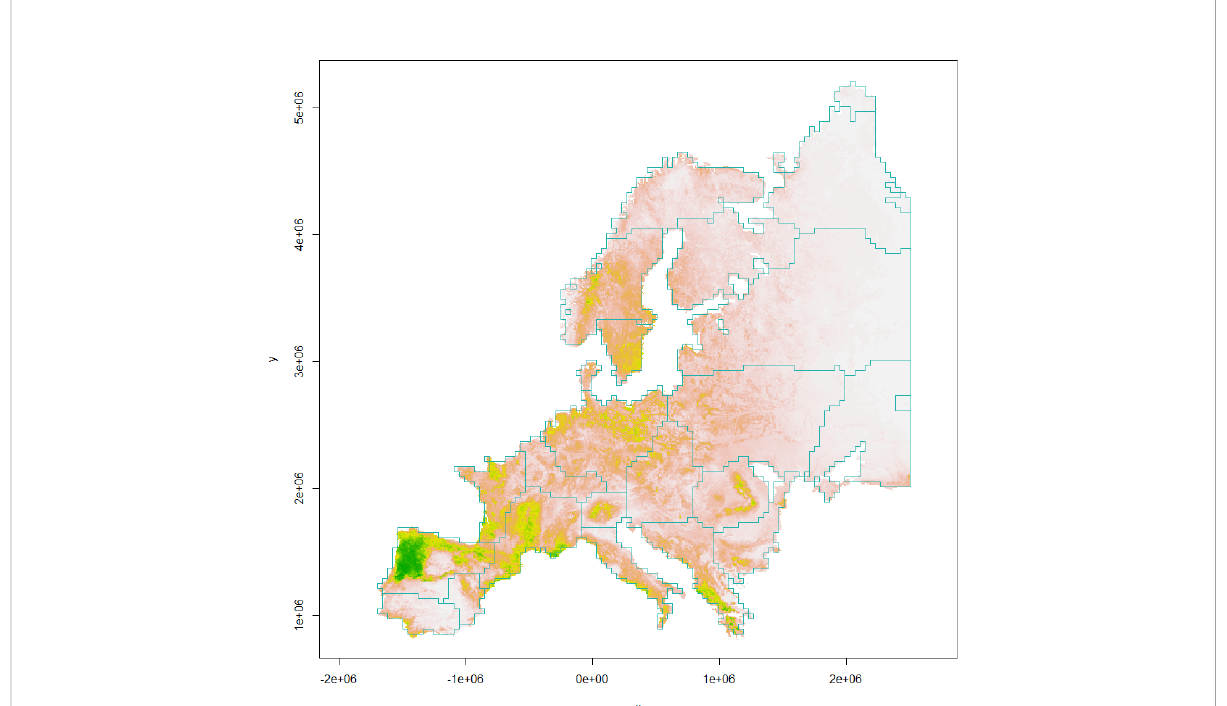
FIGURE 3 The boundaries of European gray wolf habitat clusters (light seagreen polygons) delineated from the Fast Greedy algorithm are shown against the habitat suitability index map (colors from gray to green indicating less to more suitable